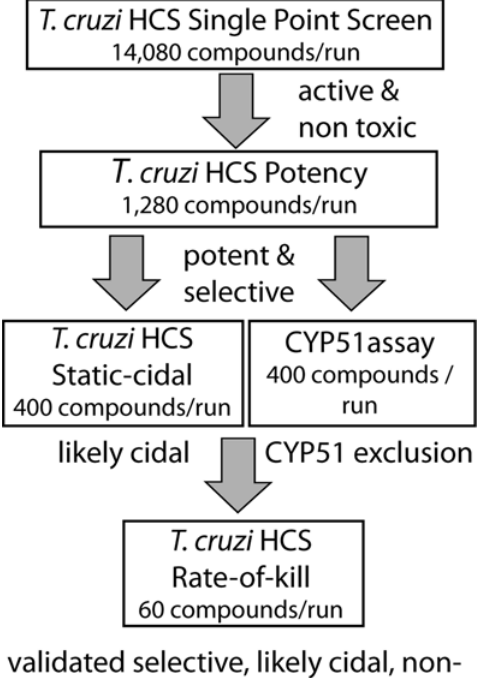
Fig 5. T . cruzi screening cascade. Schematic of T . cruzi screening cascade. Primary assay is the high- content intracellular amastigote assay at a single concentration. Compounds that achieve a set level of inhibition of amastigotes and show no toxicity against the host cells are progressed to potency determination in the same assay (using 10 compound concentrations). A potency and selectivity cut-off are next applied (cut-offs vary based on library used, MW of compounds, etc.) and the most promising compounds are progressed to the static-cidal assay to predict cidality and to the CYP51 assay to identify any compounds that may act through this target. Compounds that are predicted to be cidal and CYP51 independent are further progressed into the rate-of-kill assay and eventually into a hits-to-lead